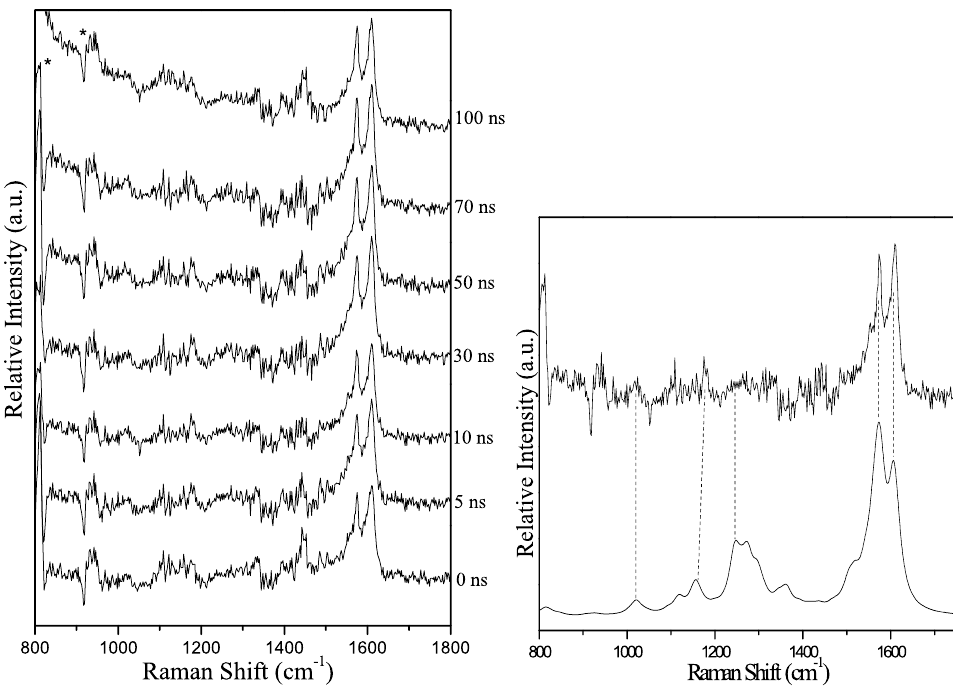
Figure 7. (Left) The ns-TR 3 spectra of 2.0 × 10 − 3 M of PPAQ after 266 nm photoexcitation in IPA using a 416 nm probe wavelength at various time delays indicated next to the spectra are shown. The asterisk ( * ) marks regions affected by stray light. (Right) Comparison of ( a ) the experimental Raman spectrum obtained at 10 ns time delay of PPAQ in IPA to ( b ) the calculated normal Raman spectrum of the ketyl radical species of PPAQ.